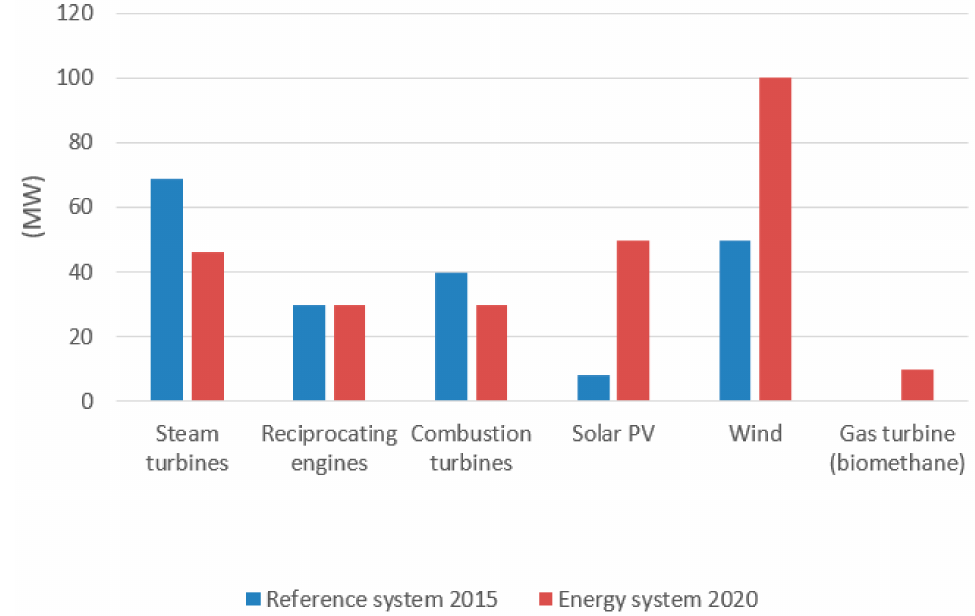
Figure 1. Installed capacities of different technologies in the year 2015 and 2020.